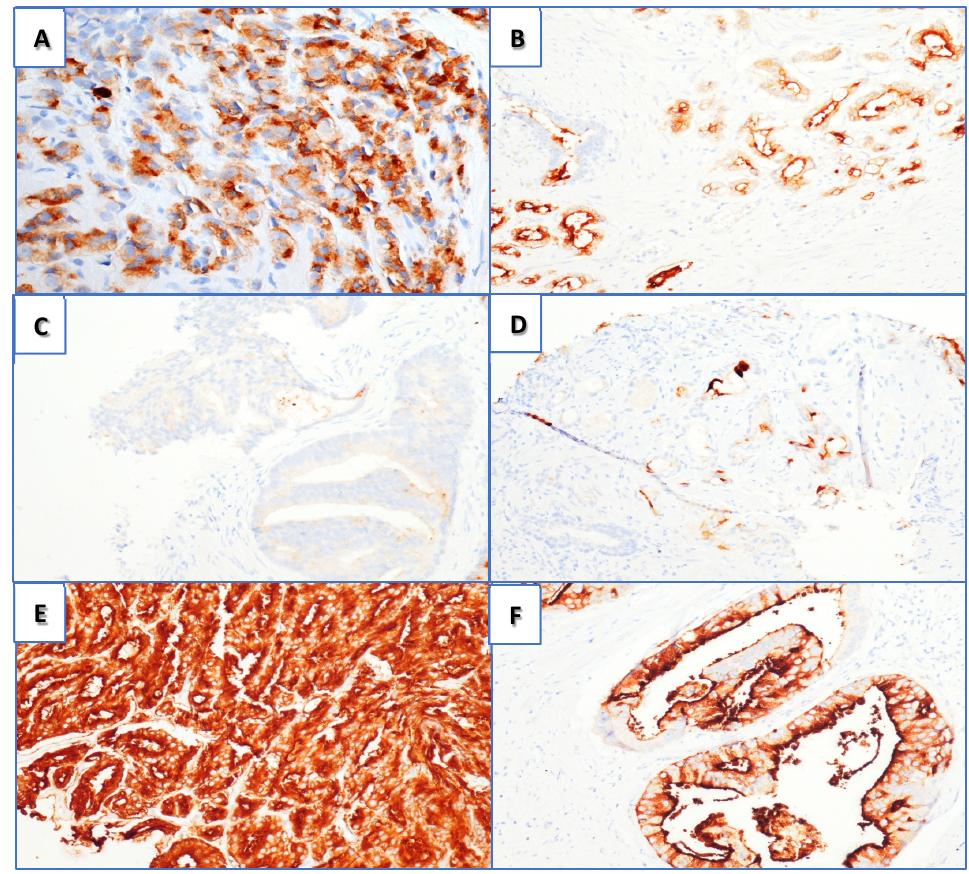
Figure 1. PSMA immunohistochemistry (magnification 20×): ( A ) cytoplasmatic immunoreaction; ( B ) membranous positivity. Visual score for PSMA positivity: ( C ) score 0, ( D ) score 1+, ( E ) score 2+, and ( F ) score 3+ (both cytoplasmic and membranous positivity).